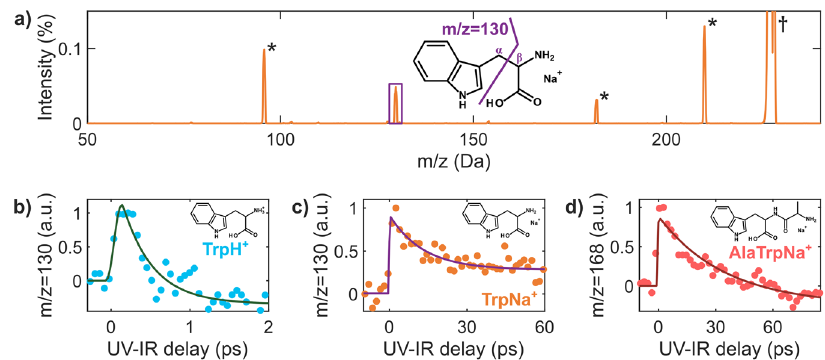
Fig. 2 Time-resolved ππ * – πσ * dynamics in tryptophan-containing charged peptides. a Mass spectrum of sodiated tryptophan ( m/z = 227, indicated by the † marker), obtained after UV irradiation. The * markers depict residual (CID) fragments, and the structure of fragment m/z = 130 (C α – C β cleavage in purple) is shown. Intensity on the y -axis represents the signal normalized on the parent intensity (i.e., m/z = 227 is 100%). b Normalized time-dependent yield of fragment m/z = 130 in TrpH + , as a function of the UV pump – IR probe delay (blue dots), together with its exponential fi t (dark green line), yielding a timescale of 390 ± 100 fs. c , d Same analysis for TrpNa + (orange dots) and AlaTrpNa + (red dots), giving timescales of 13 ± 3 ps (purple line) and 35 ± 8 ps (dark red line) respectively. The chemical structure of the three molecules is shown in each box. In the case of AlaTrpNa + , fragment m/z = 130 is not observed, and the dynamics is observed in, e.g., fragment m/z = 168, as shown in ( d ) and in Supplementary